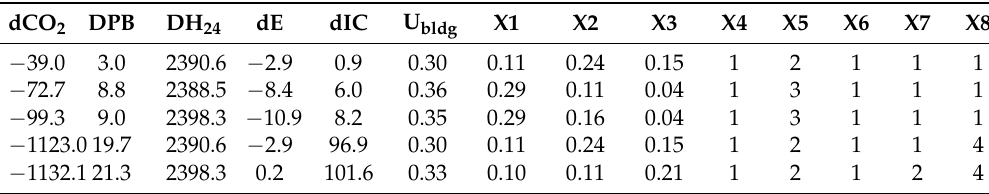
Table A3. Optimal Pareto solutions for Case 1 ( P 2).